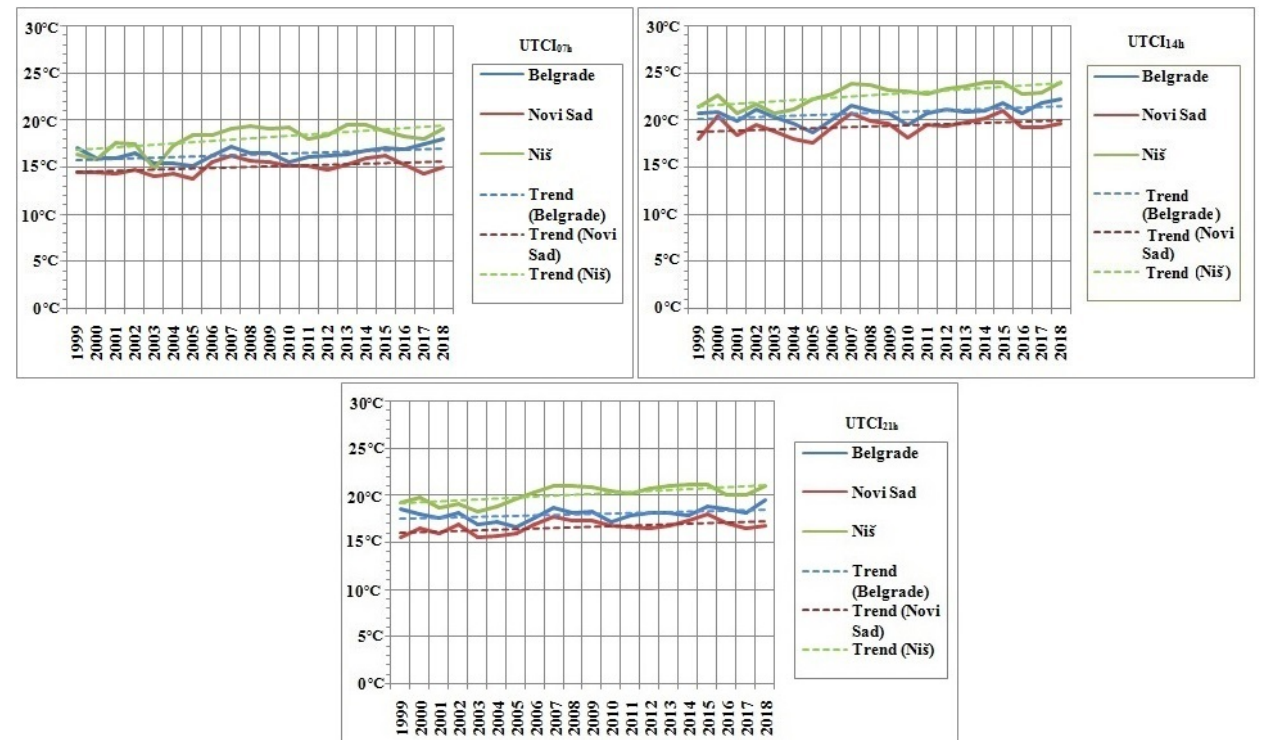
Figure 6. Average annual UTCI at 7 h, 14 h and 21 h CET during the period 1999–2018. Blue indicates UTCI values and trends for Belgrade, red is used for Novi Sad, and green for Niš.